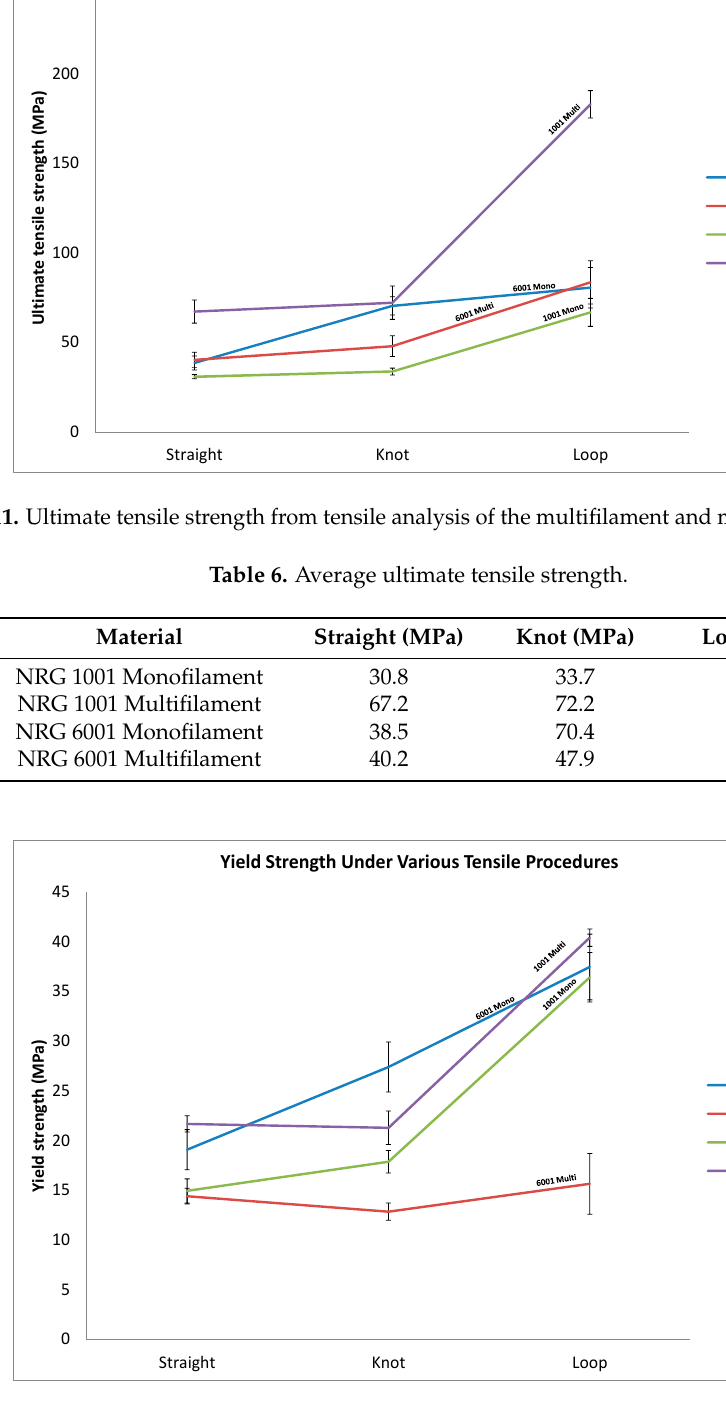
Figure 12. Yield strength from tensile analysis of the multifilament and monofilament fibres.